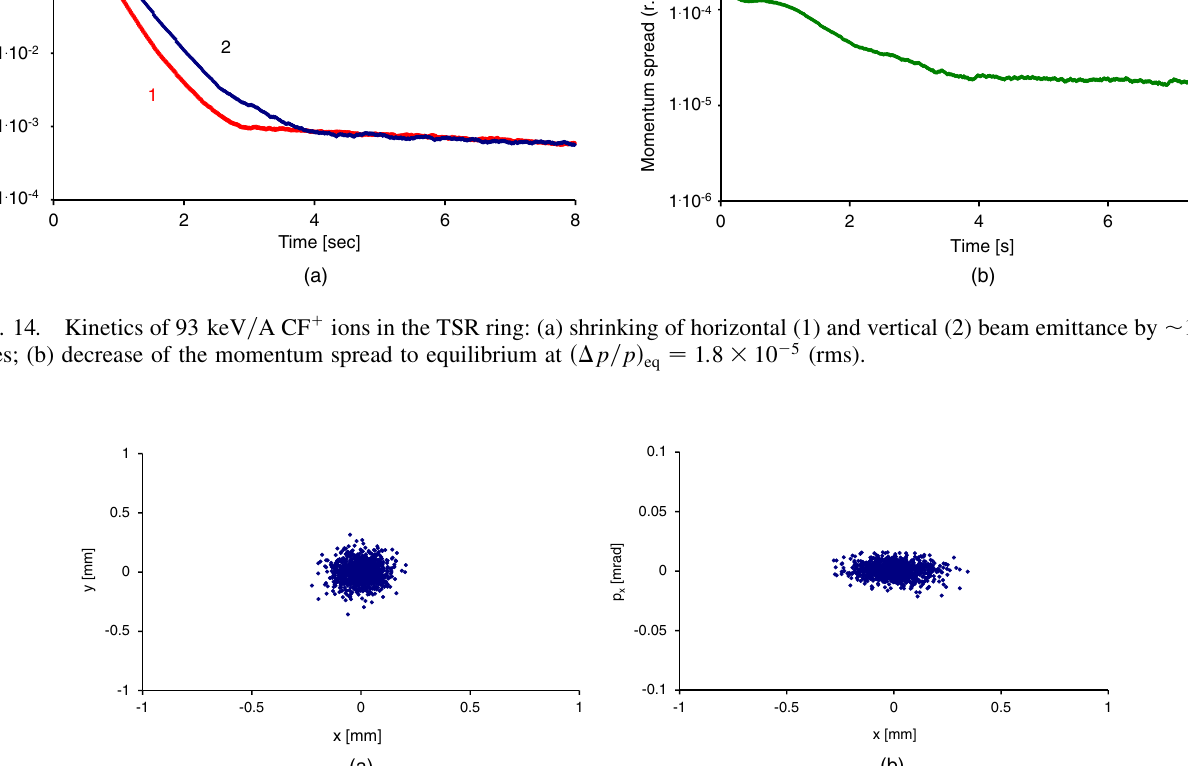
FIG. 15. Profiles of cooled CF þ beam: (a) x - y cross section in equilibrium, beam radius (cid:8) 0 : 2 mm ; (b) x - x 0 phase space, the rms beam width (cid:11) x;y rms ¼ 0 : 06 – 0 : 07 mm corresponds to equilibrium emittance " eq x;y ¼ 6 (cid:6) 10 (cid:3) 4 (cid:4) mm mrad (rms).